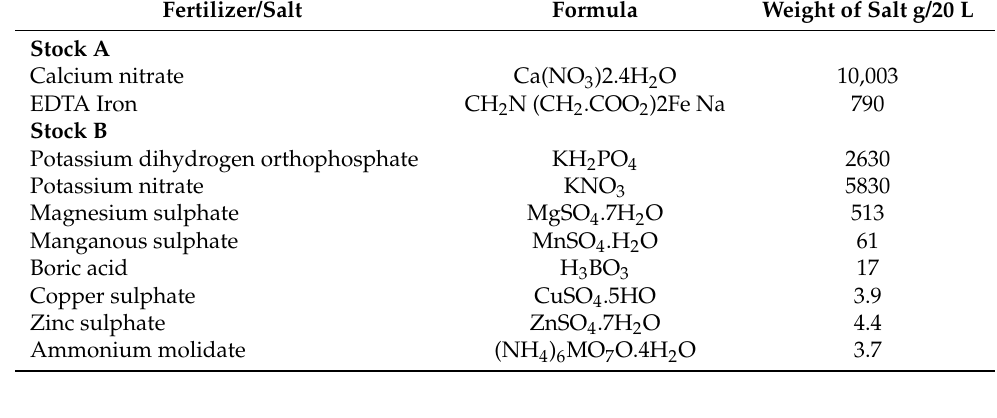
Table A1. Nutrient solution formulation and chemical characteristics applied in the study [92].